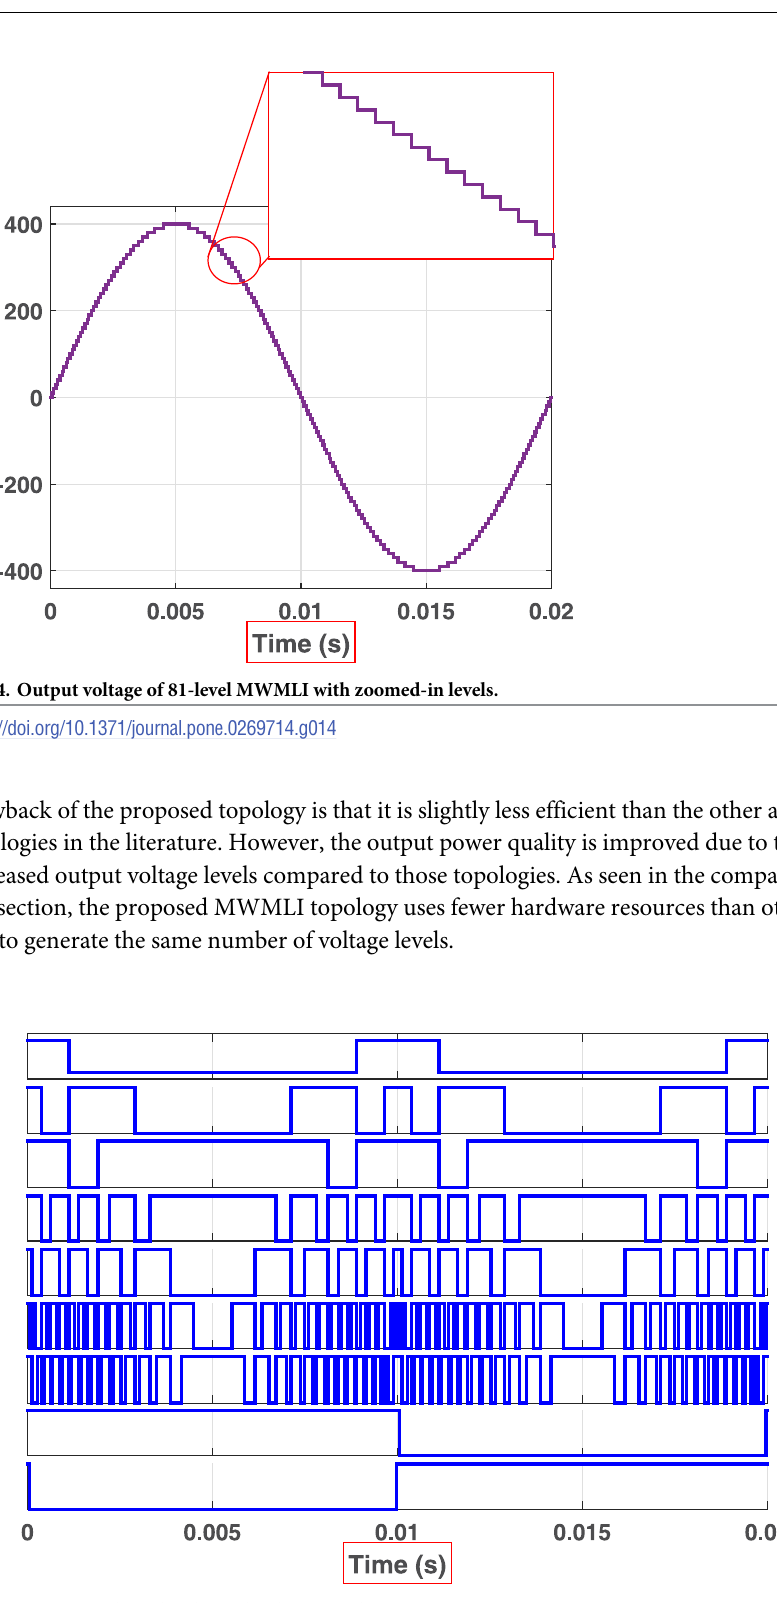
Fig 15. PWM waveform for the 81-level proposed